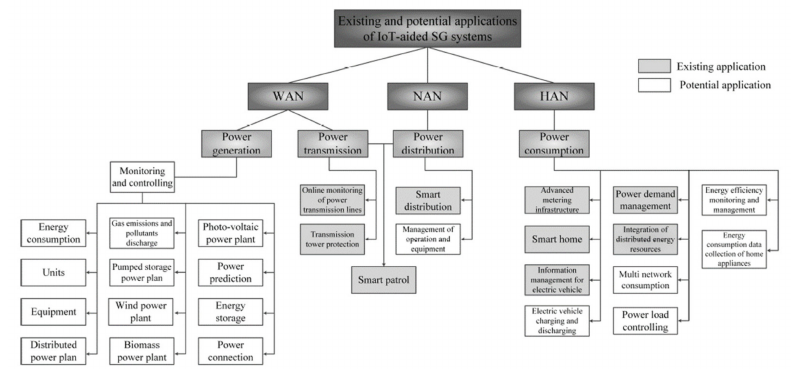
Figure 1. Existing and potential applications of IoT-aided smart grid (SG) systems are classified into Wide Area Network (WAN), Neighborhood Area Network (NAN), and Home Area Network (HAN)